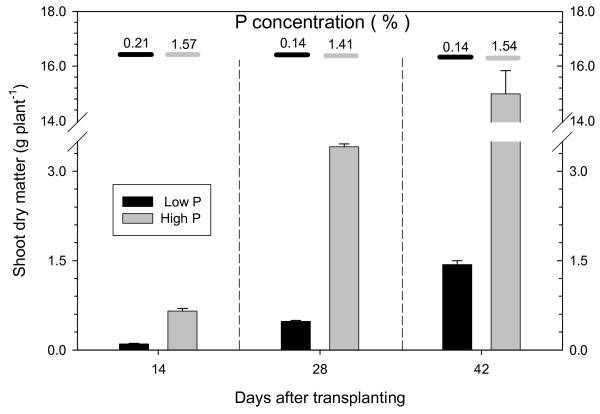
Dependance of shoot dry weight and P content on P supply. Shoot dry matter and P concentration of sugar beet grown in nutrient solution containing initially 2 (low P) or 500 (high P) μM P is shown. Values from three harvest times are given as means ± standard error of 3 replicates.